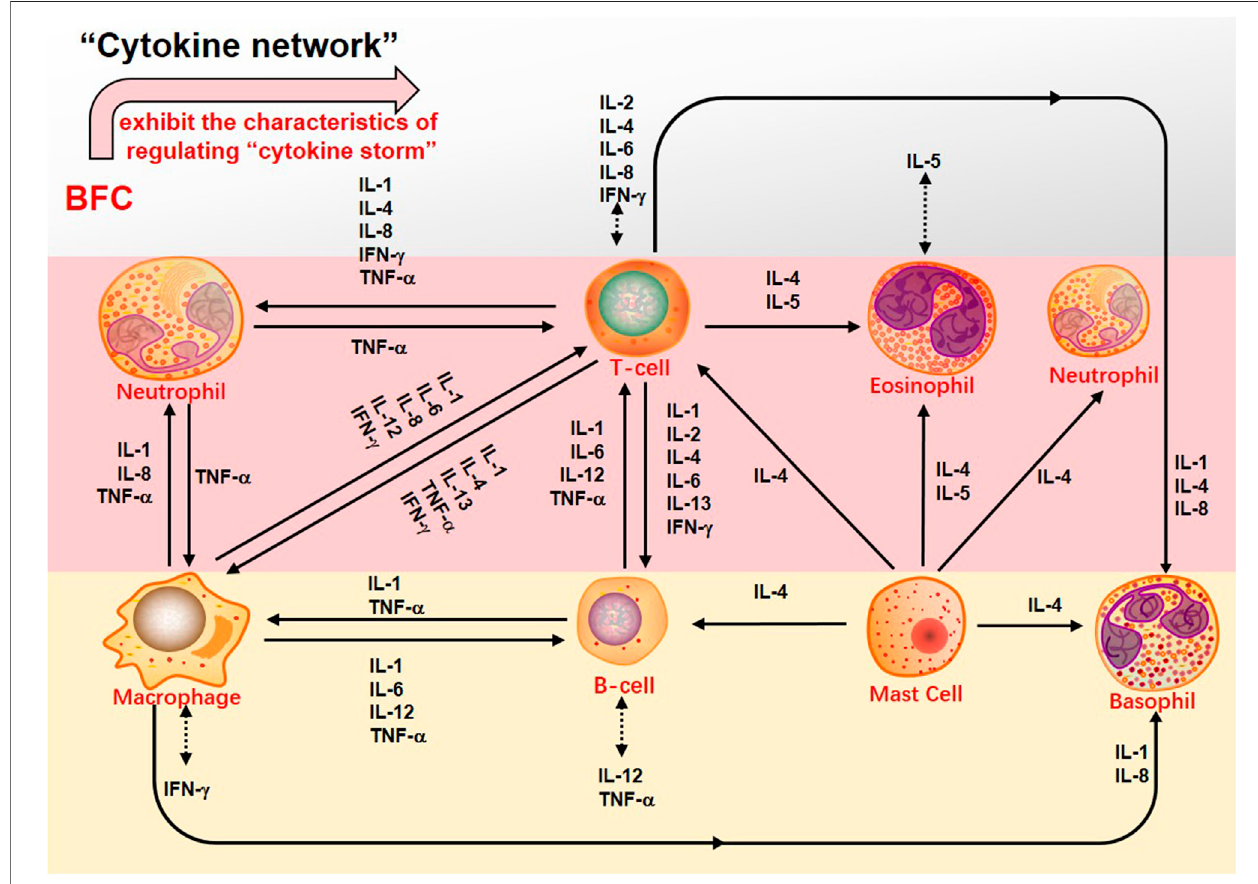
FIGURE 9 | BFC exhibits the characteristics of regulating the “ cytokine storm ” .